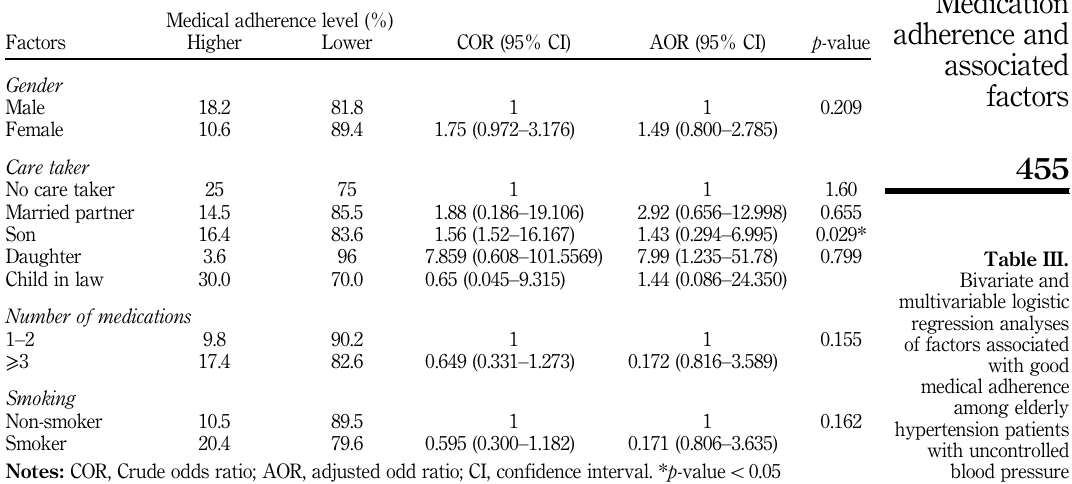
Table III. Bivariate